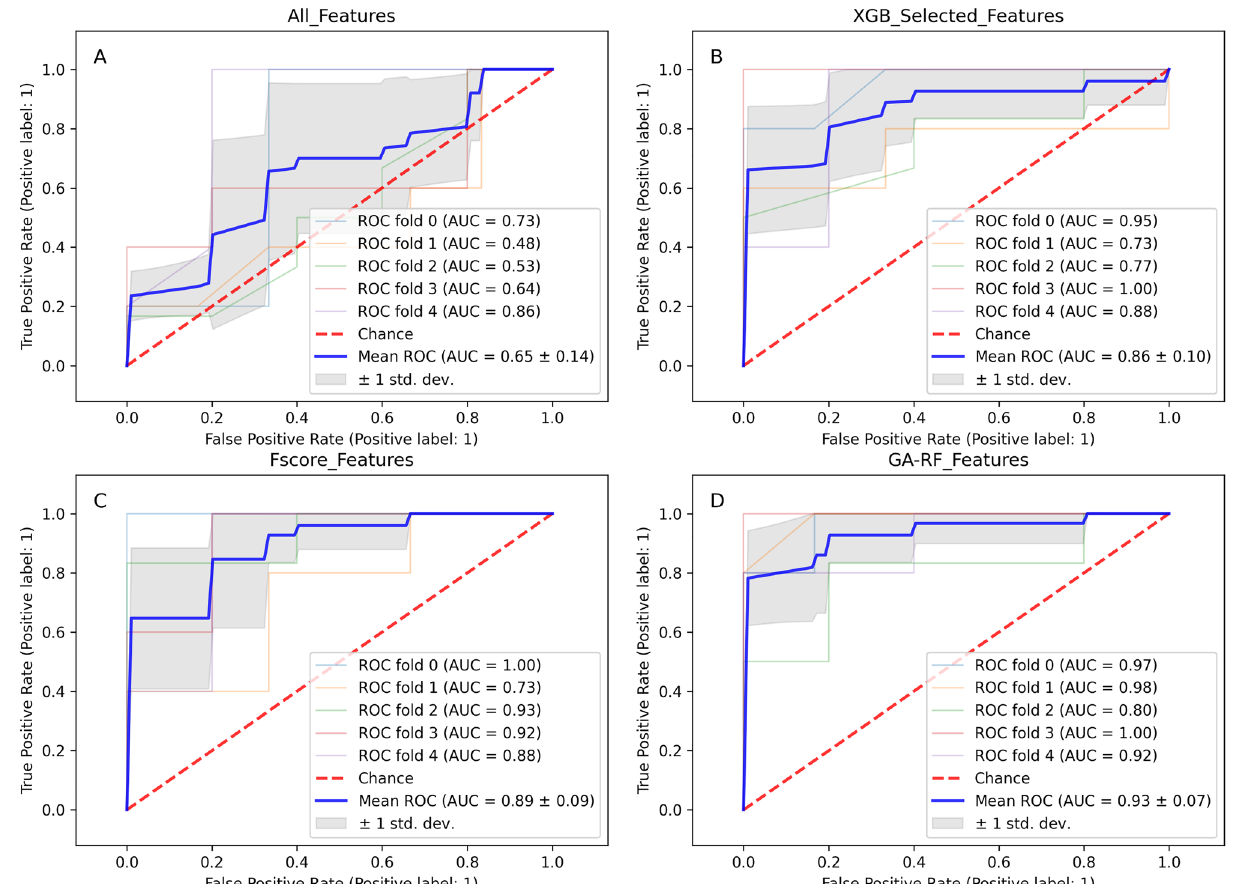
Figure 4. Receiver operating characteristic (ROC) curves of different feature sets as evaluated by the random forest (RF) algorithm. The feature sets are: ( A ) all 704 radiomics features; ( B ) 38 features selected by XGBoost; ( C ) the feature set selected by F-scores; and ( D ) the feature set selected by the genetic algorithm (GA)-RF